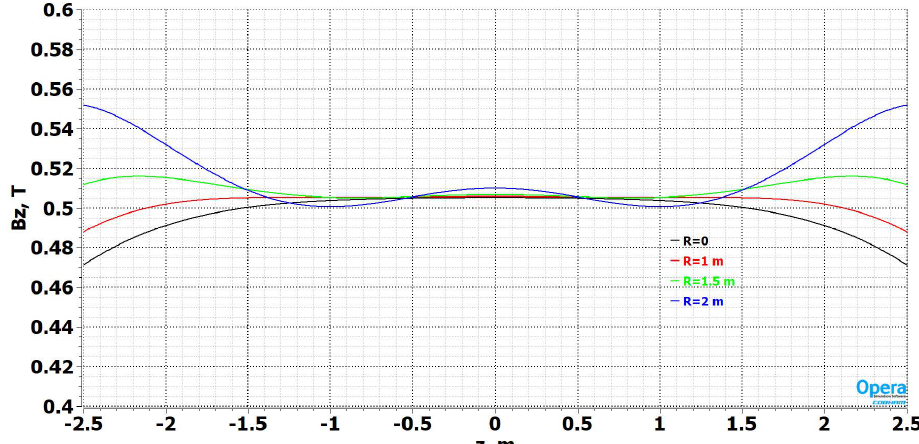
Figure 55. Field map of the 5-coil Helmholtz superconducting magnet along the z axis. The colors represent different radii from the center line. The horizontal scale shows the position along the symmetry axis of the magnet (called z here). The vertical scale shows the component of the magnetic field in the direction of the symmetry